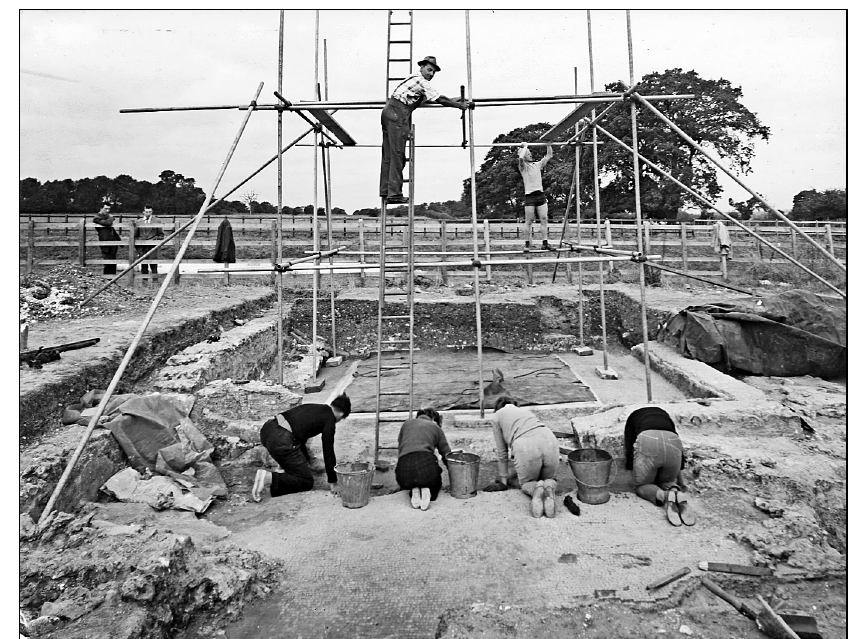
Figure 6 Preparations for Maurice Cookson to take a vertical photograph of the mosaic in insula XXI , building 2, Verulamium, 1959.